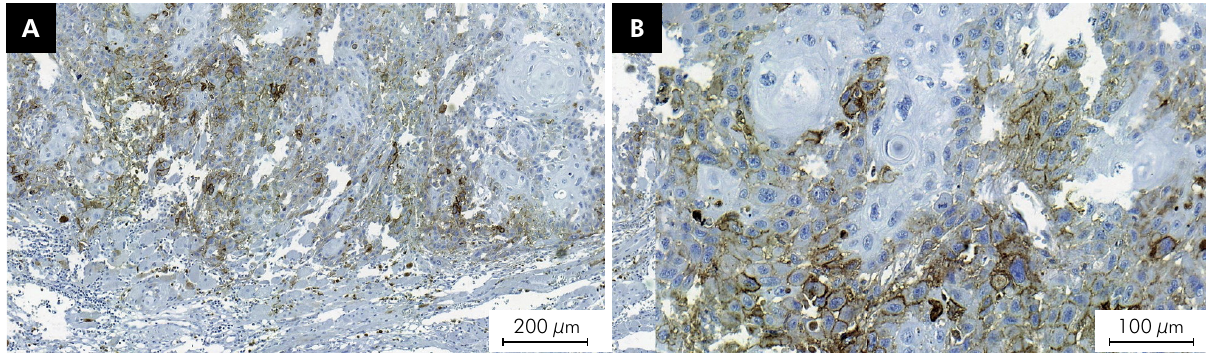
Figure 2. Immunohistochemical expression of uPAR in SCCOT. (a) Low magnification showing the immunostaining at the invasion front and in the tumor core. (b) High magnification showing the immunostaining at the invasion